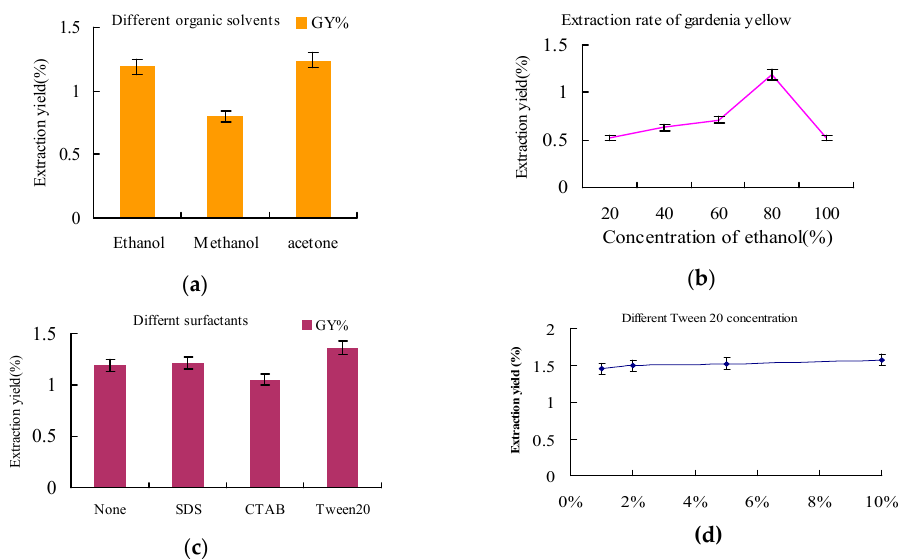
Figure 3. The influence of: ( a ) different 80% organic solvents (liquid-solid ratio 20:1 at its own reflux temperature for 5 min, no additive); ( b ) ethanol concetration (liquid-solid ratio 20:1 at 80 °C for 5 min, no additive); ( c ) different surfactants (80% ethanol solution, liquid-solid ratio 20:1 at 80 °C for 5 min) on yield of gardenia yellow; ( d ) different concentration of Tween 20 (80% ethanol solution, liquid-solid ratio 20:1 at 80 °C for 5 min) on yield of gardenia yellow.